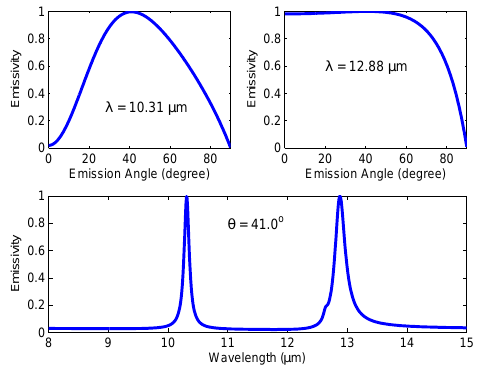
Figure 10: Top panels: emissivity vs. emission angle at the perfect emission wavelength of the shorter wavelength band (left panel, λ = 10 . 31 µ m) and the longer wavelength band (right panel, λ = 12 . 88 µ m). Bottom panel: emissivity vs. wavelength at the emission angle θ = 41 . 0 ◦